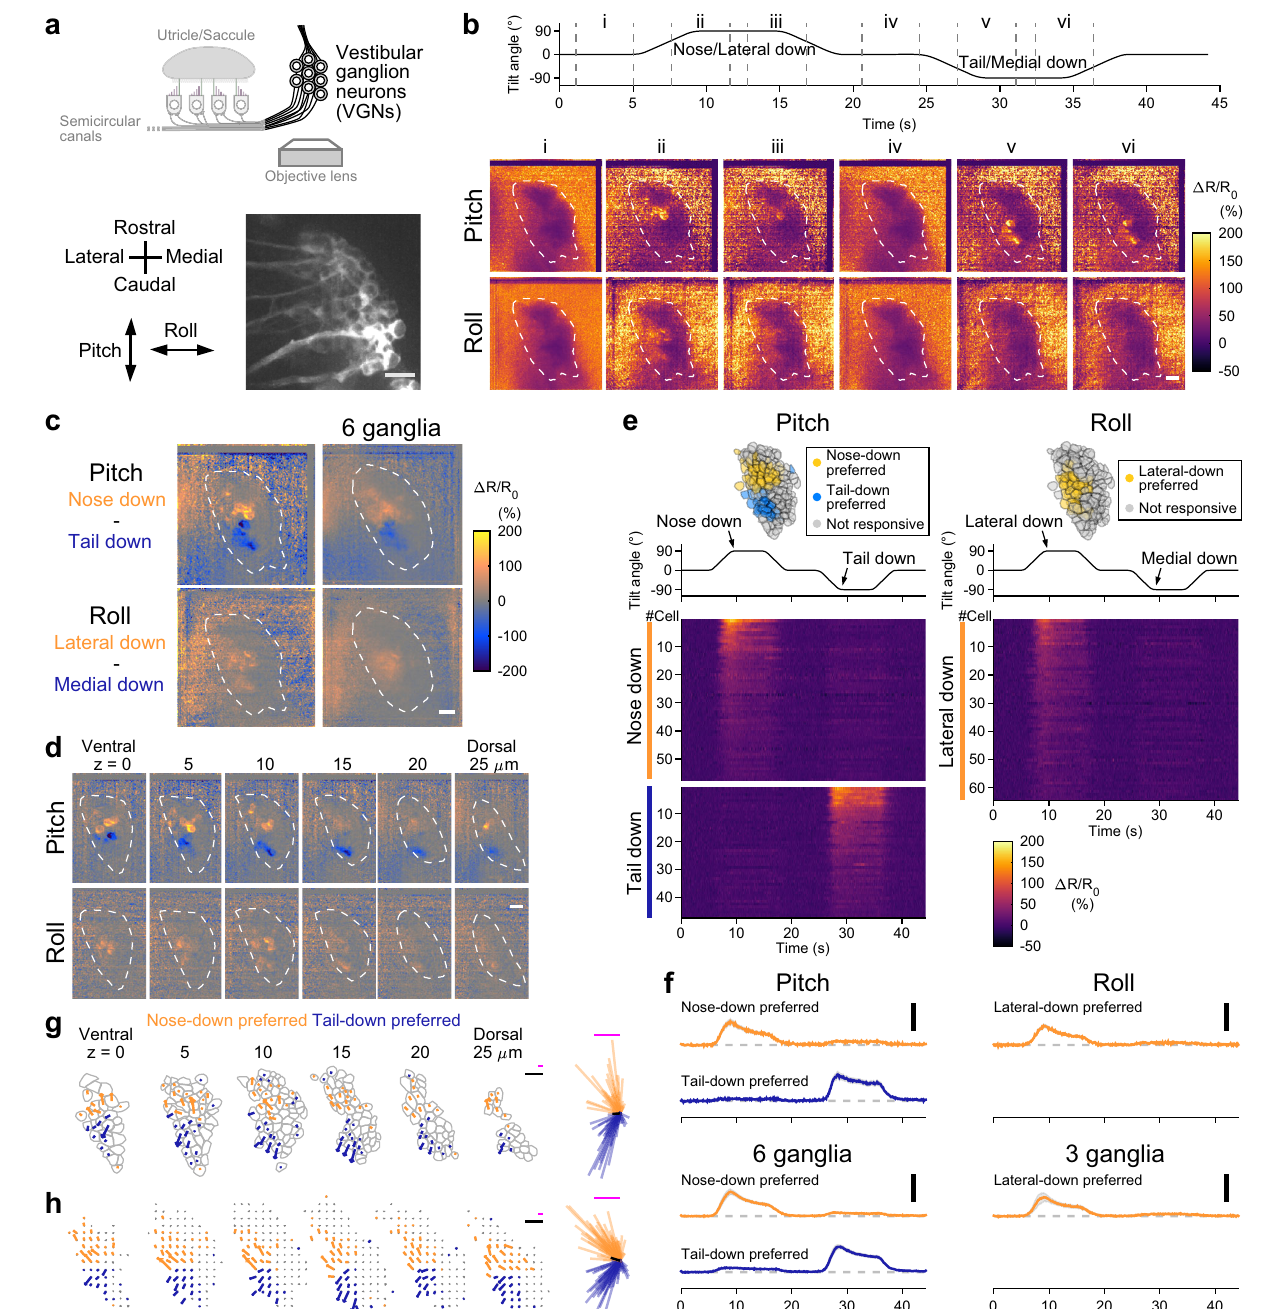
Fig. 5 | Topographic representation ofhead tilt directionin VGNs.a Imaging of VGNs (top). VGNs in the rostral division of VG in a 5 dpf Tg(myo6b:jGCaMP7f; myo6b:tdTomato) larvaimagedfrom ventral(bottom).Red channelis shown.Scale bar:10 μ m.Thesameorientationappliesto( b ) – ( e ),( g ),and( h ). b VGNresponsesto 90° static tilt (see Supplementary Movie 5). Tilt time course (top). Sequential images showing mean Δ R / R 0 responsesduring the time period “ i ” to “ vi ” (bottom). Maximumintensityprojectionofsixopticalsliceswith5 μ mintervals.Singletrialat eachslice.Dashedlines:VGcontours.Scalebar:10 μ m.Thesameganglionisshown in ( c ),( d ),( e ),and ( g ).Response selectivity fortilt direction in images of maximum intensity projection ( c ) and different depth ( d ). Tail-down response ( “ v ” in [ b ]) subtracted from nose-down response ( “ ii ” in [ b ]) (top). Medial-down response ( “ v ” in [ b ]) subtracted from lateral-down response ( “ ii ” in [ b ]) (bottom). Dashed lines: VGcontours.Scalebar:10 μ m.Averageof6ganglia([ c ],right). e Tiltresponsesper VGN. VGN location (top, 6 optical slices overlaid). Tilt time course (middle). Δ R / R 0